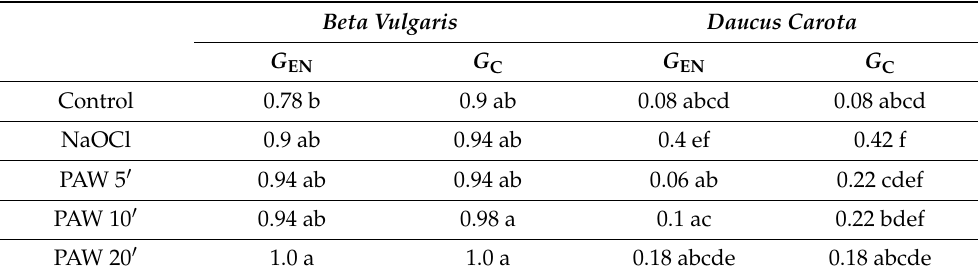
Table 3. Statistical analysis of germination results. The letter indicators next to the means determine the statistically homogeneous